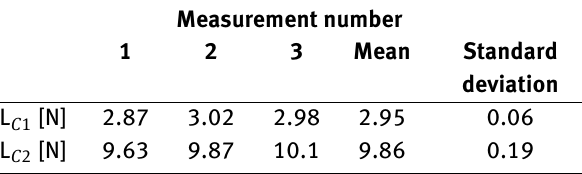
Table 2: The adhesion tests of diamond-like carbon